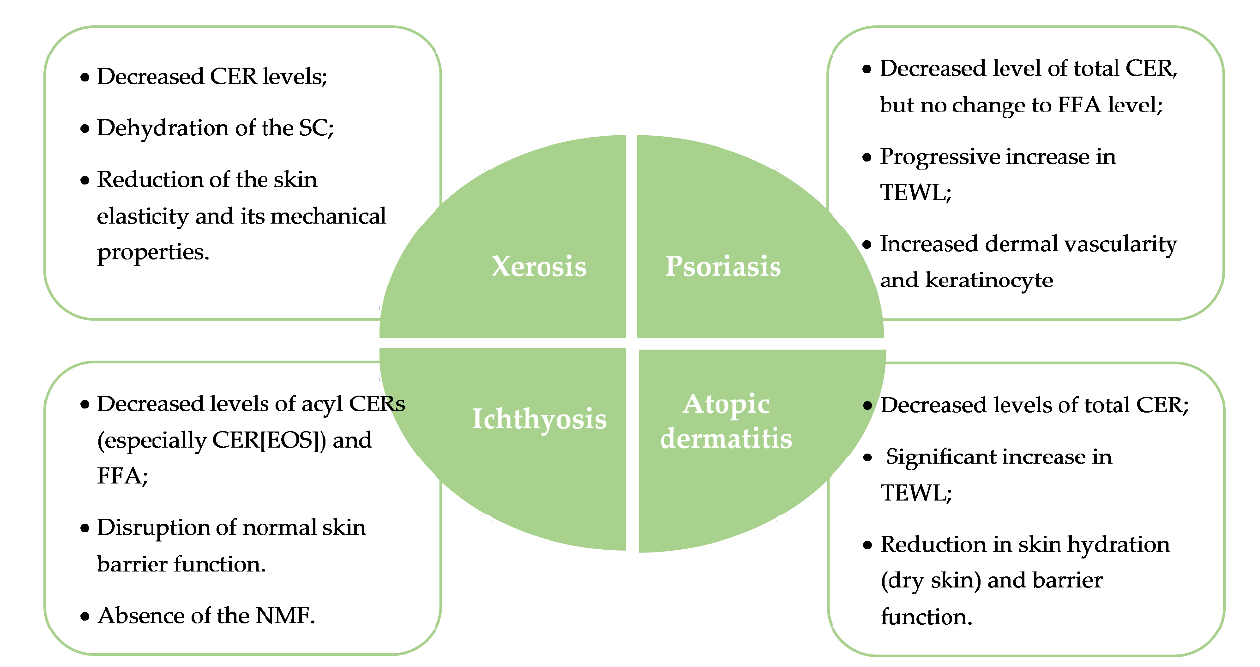
Figure 2. Brief schematic representation of some common skin diseases associated with epidermal barrier impairment and their main effects on barrier function of skin.